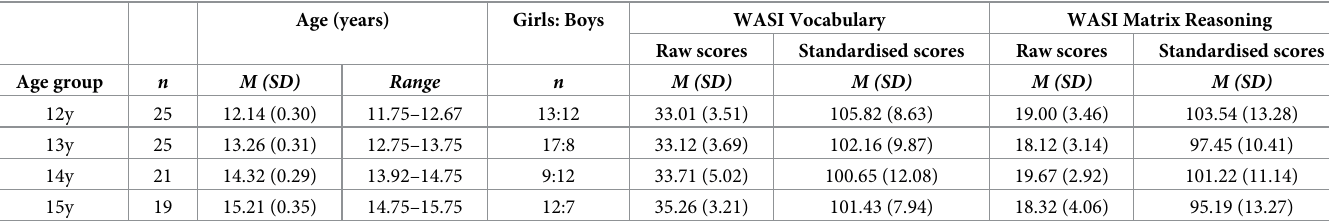
Table 1. Participant